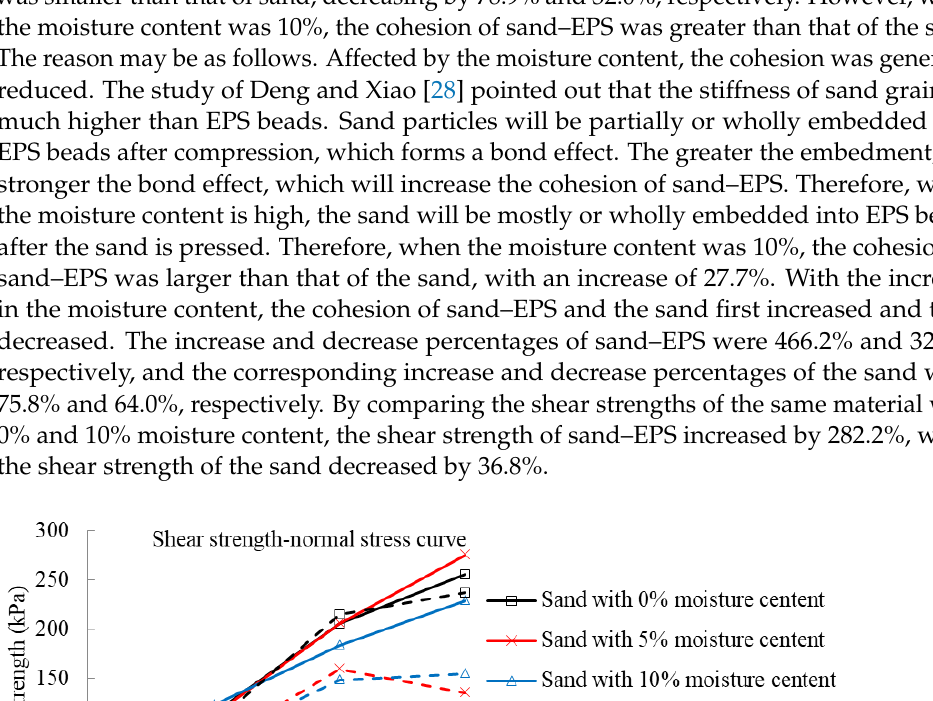
Figure 8. Shear-strength – normal stress curves for different moisture content.